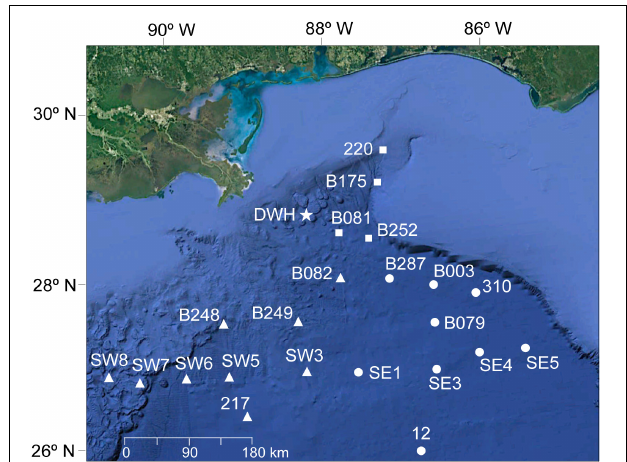
FIGURE 1 | Map showing the location of 22 stations across three areas in the northern Gulf of Mexico relative to the Deepwater Horizon wellhead site (shown as a star). Areas include: north (shown as squares), south (triangles), and southeast (circles). Background map: Google Earth (version 7.3, 2019).